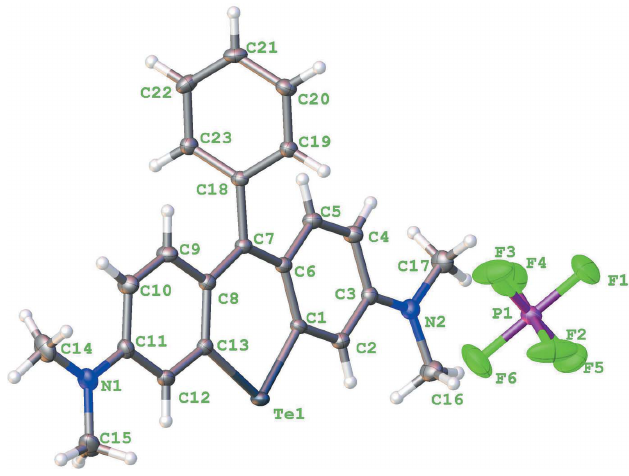
Figure 1 Asymmetric unit of the title compound with displacement ellipsoids drawn at 50%.